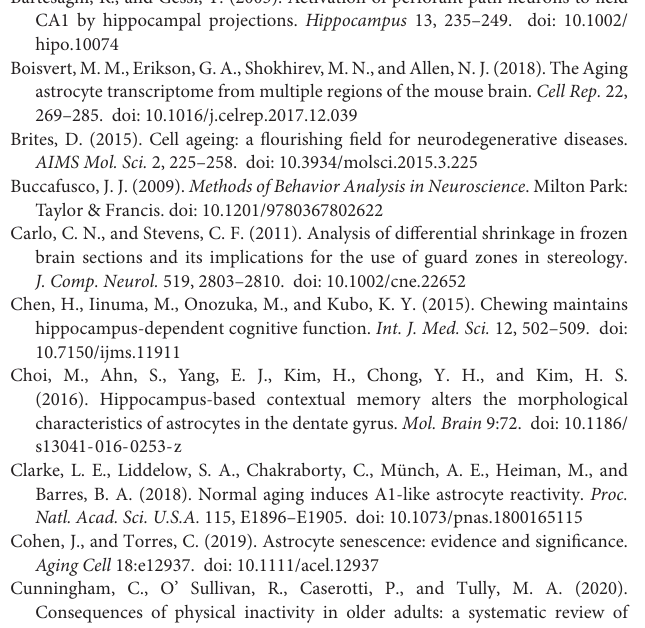
Supplementary Table 1 | Data obtained for astrocytes from the discriminant analysis made on morphological variables with multimodal index (MMI) > 0.55 for all experimental groups. Supplementary Table 2 | Representation of the mean values and standard error for the complexity of the astrocytes of each phenotype (AST1 and AST2) and t -student test ( t ), with respective p -values ( p ) for the comparison between them, obtained from the test (HD, HD/SD, or HD/SD/HD), for each experimental group, according to the environment (impoverished and enriched), at the ages of 6 and 18 months (6M and 18M). Supplementary Table 3 | Representation of values obtained after Analysis of Variance (ANOVA) – one way (Fisher- F ) and t -student test ( t ), with respective p -values ( p ) in comparison of the complexity of the branches of the astrocytes (HD, HD/SD, and HD/SD/HD) and age (6 months: 6M and 18 months: 18M), raised in an impoverished environment – IE and enriched – EE. Supplementary Table 4 | Representation of values obtained after Analysis of Variance (ANOVA) – one way (Fisher- F ) and t -student test ( t ), with respective p -values ( p ) in the comparison of the complexity of the branches of the astrocytes (HD, HD/SD, and HD/SD/HD) and age (6 months: 6M and 18 months: 18M), raised in an impoverished environment – IE and enriched –